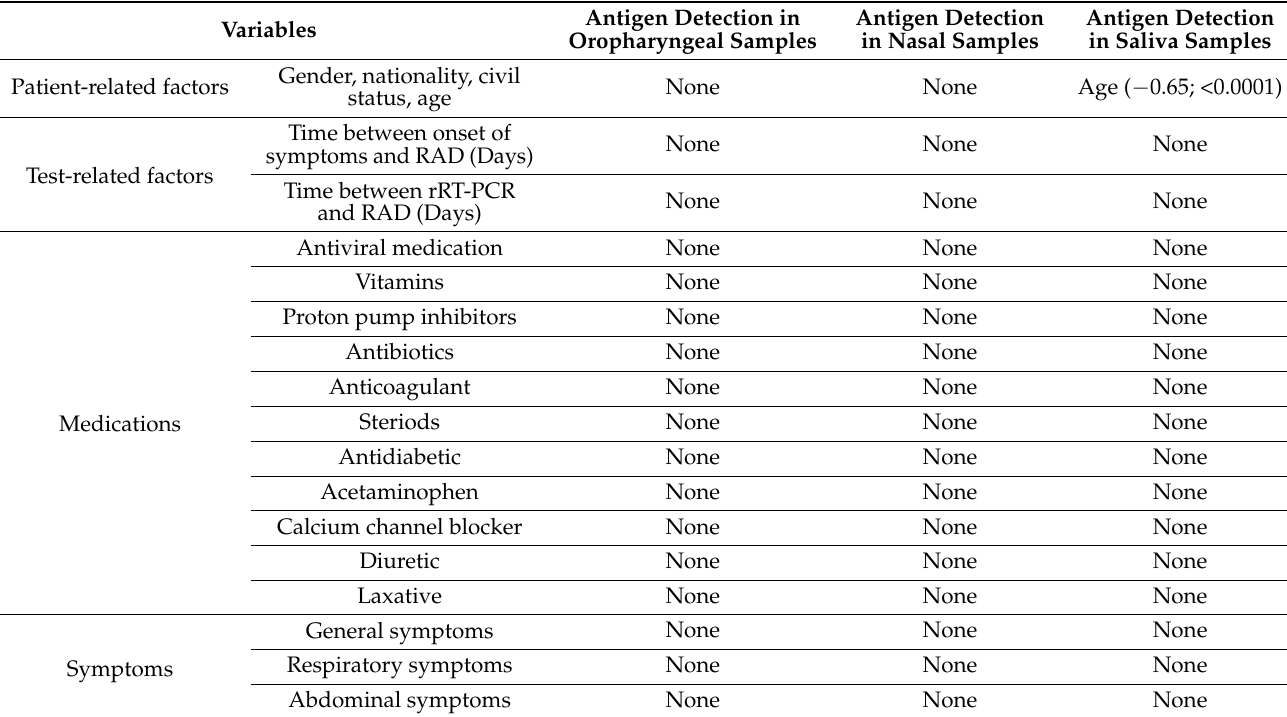
Table 4. Correlation analysis. The table shows all study variables entered in the Pearson bivariate correlation matrix with respect to positive antigen detection using the different sampling methods in the COVID-19-confirmed patients (n = 50). The statistically significant correlation is presented with its correlation coefficient (r) and level of significance ( p